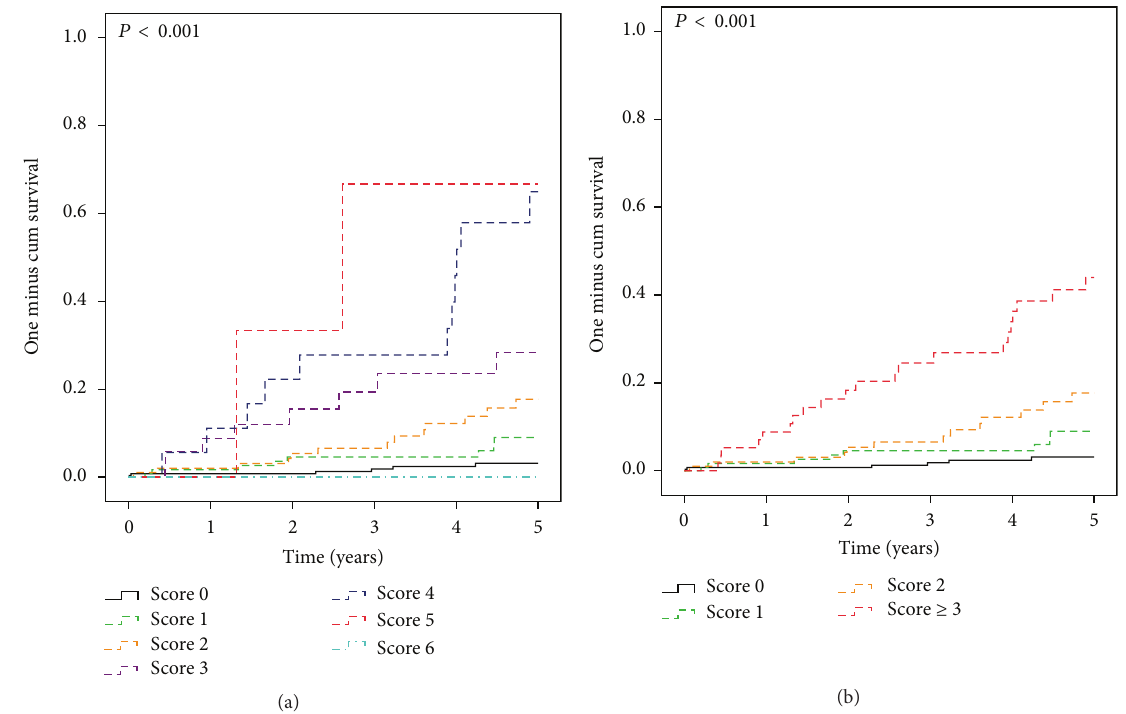
Figure 2: (a) MACEs risk stratified by CHADS 2 score. (b) MACEs risk stratified by CHADS 2 score